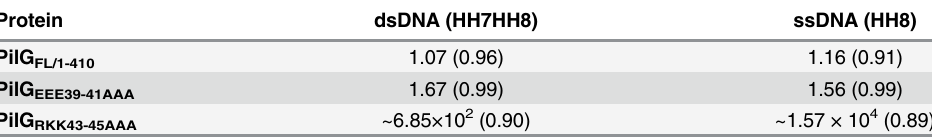
Table 5. Best-fit values for k half (= EC 50 , in [ μ M]) for the EMSA analysis of wild type and mutant PilG proteins using DUS containing substrates. The k prime and h values were calculated using GraphPad Prism 5 [75] and converted into k half values. The goodness of fit is given as R 2 values in parentheses. Due to the conditions used in the EMSA k half is approximately equal to kd [63].